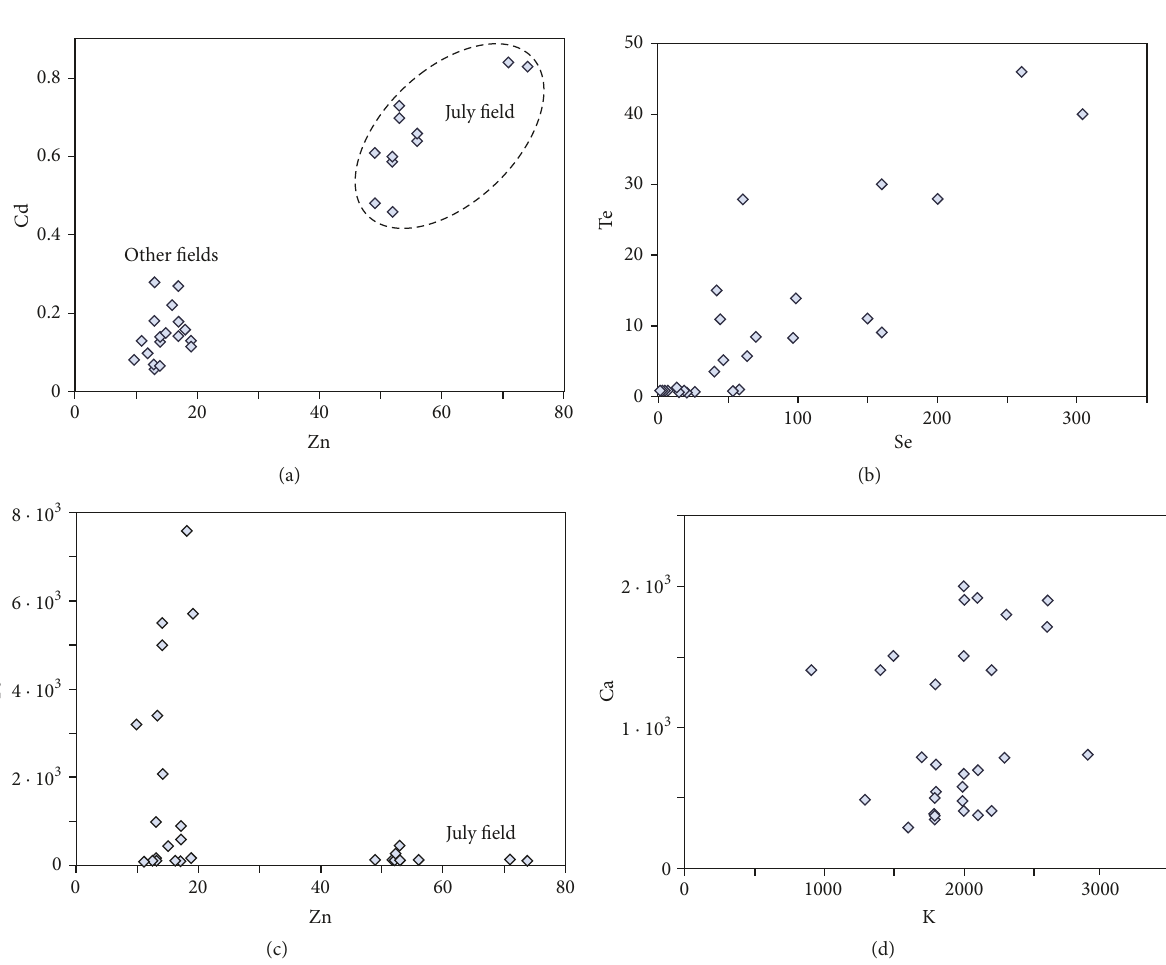
Some rare phases were observed, such as palladium